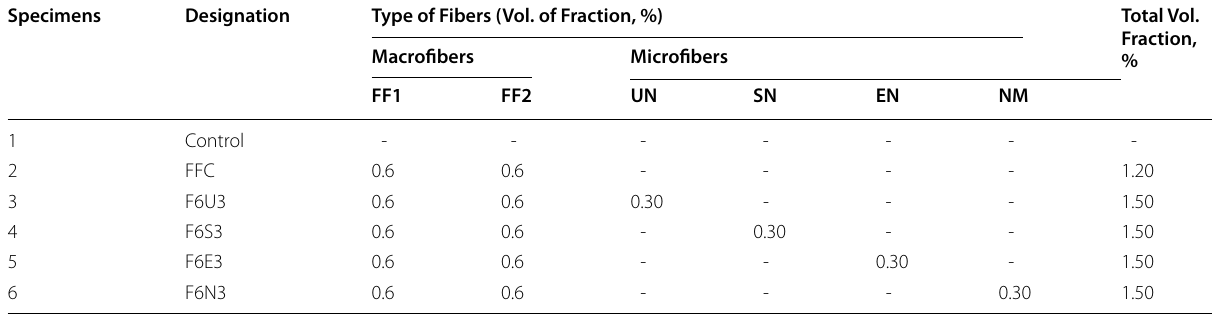
Table 2 Proposed HyFRC for Beam–Column joint (C: Control; UN: Ultra-Net; SN: Super-Net; EN: Econo-Net; FF: Ferro)